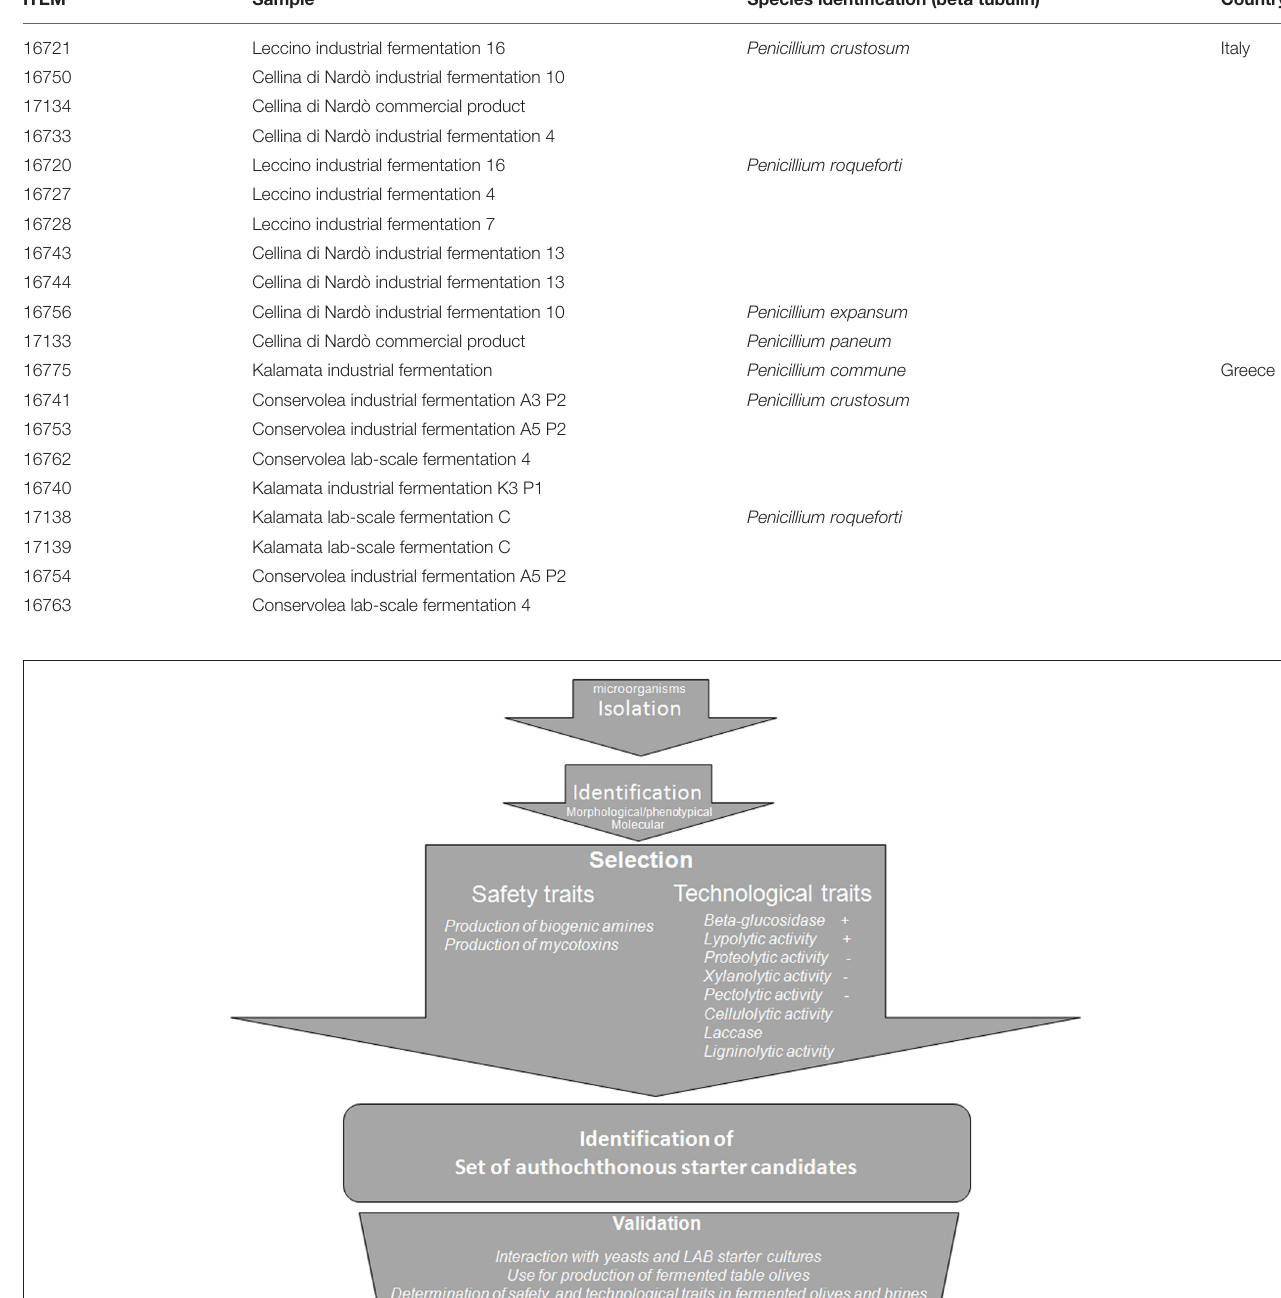
the value 2, isolates producing slight blue halo with the value 1 ( Table 2 ). None of the isolates were able to decarboxylate histidine, tyrosine and phenylalanine, precursors of histamine, tyramine and 2-phenyl-ethylamine, respectively. Only the isolate